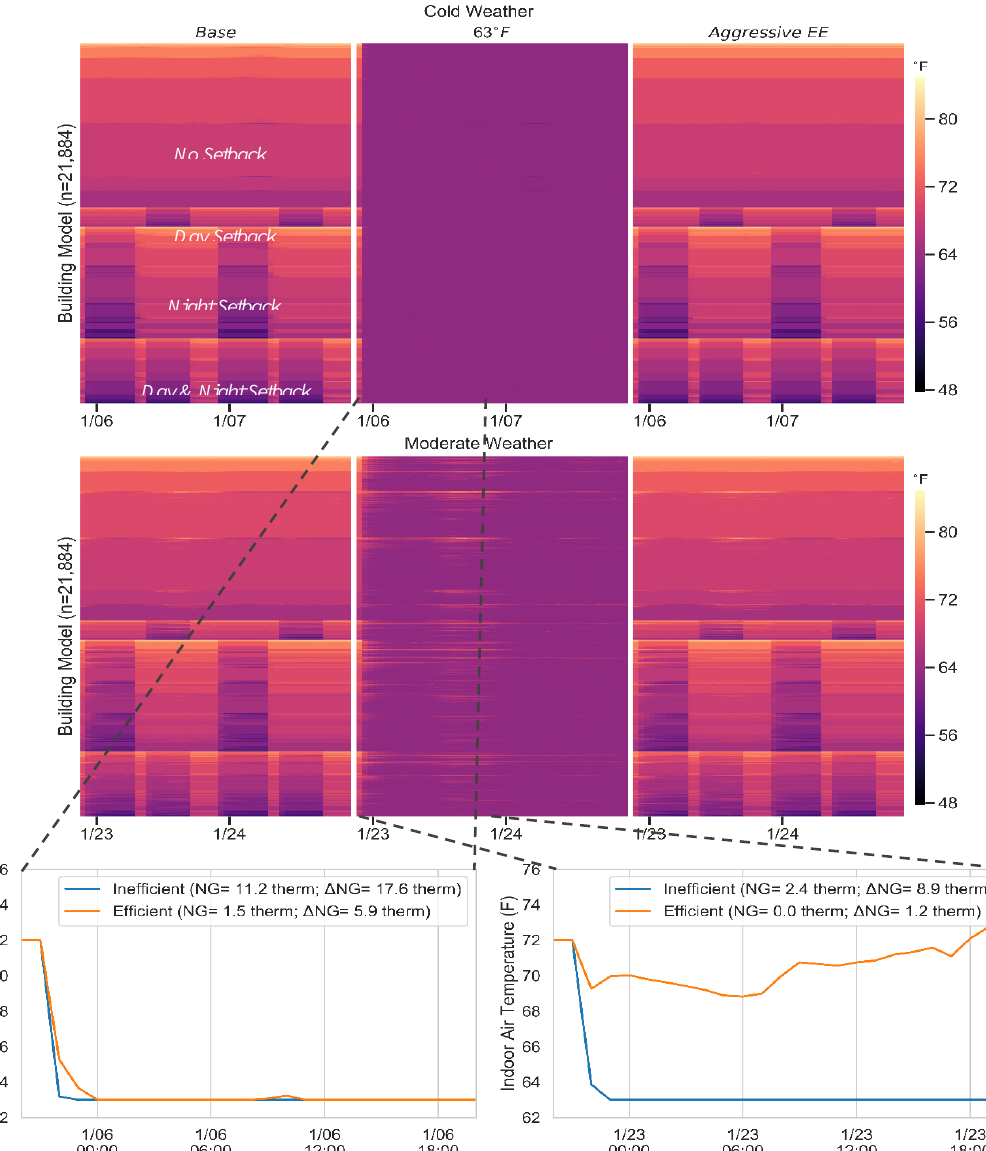
Figure 10. Heatmap of indoor air temperatures for the aggressive approach during cold temperature ( top ) and moderate temperature ( bottom ) periods in 2018. The y -axis contains each building model for which the aggressive setback was applied (94% of homes), and is sorted by existing setback and average indoor air temperature. The lower two plots show expanded views of indoor air temperatures for two homes over 24 h during the cold period ( left ) and the mild period ( right ). One model is well insulated and tightly sealed (“E ffi cient”) and the other is poorly insulated and poorly sealed (“Ine ffi